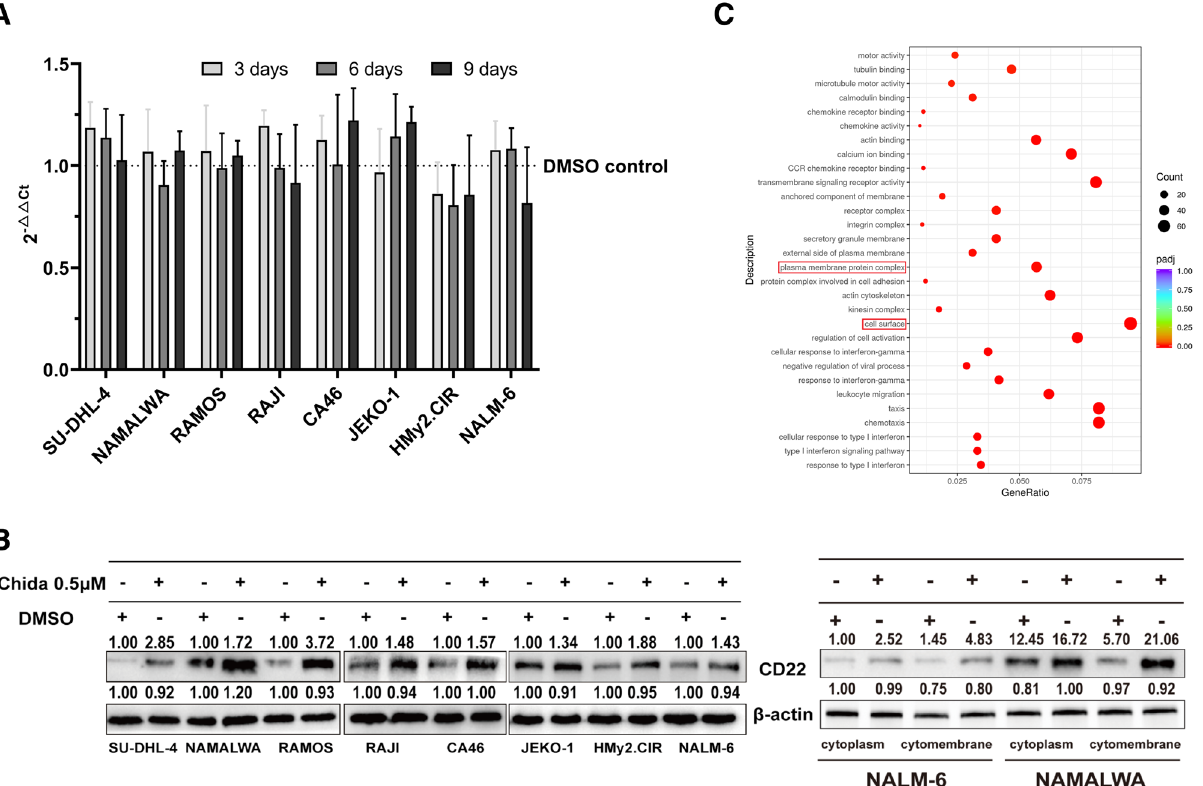
Figure 4. Chidamide-mediated surface CD22 upregulation may occur via distribution of CD22 rather than increased CD22 gene expression. ( A ) CD22 mRNA expression of Eight cell lines co-incubated with 0.5 μM Chidamide were harvested on days 3, 6 and 9 and their CD22 mRNA expression was analyzed using RT-PCR. ( B ) NALM6 and NAMALWA were co-incubated with 0.5 μM Chidamide for 72 h and the total CD22 protein as well as cytosolic and cytoplasmic CD22 proteins were detected by Western Blotting. ( C ) NALM6 and NAMALWA co-incubated with 0.5 μM Chidamide for 72 h were harvested and a transcriptome sequencing analysis was